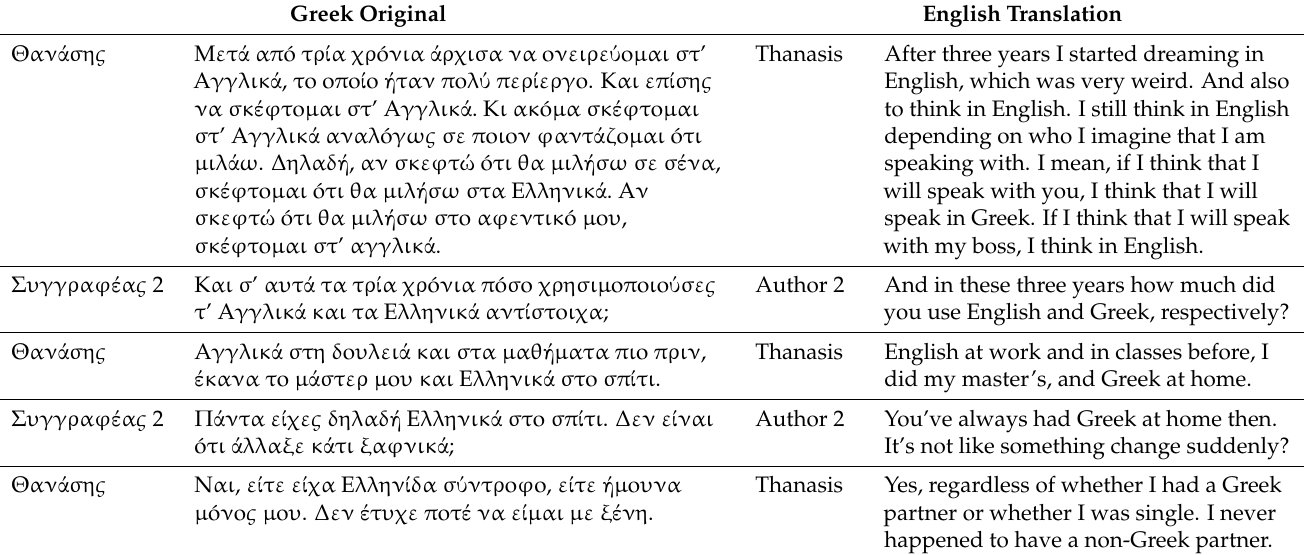
Table 6. “I started dreaming in